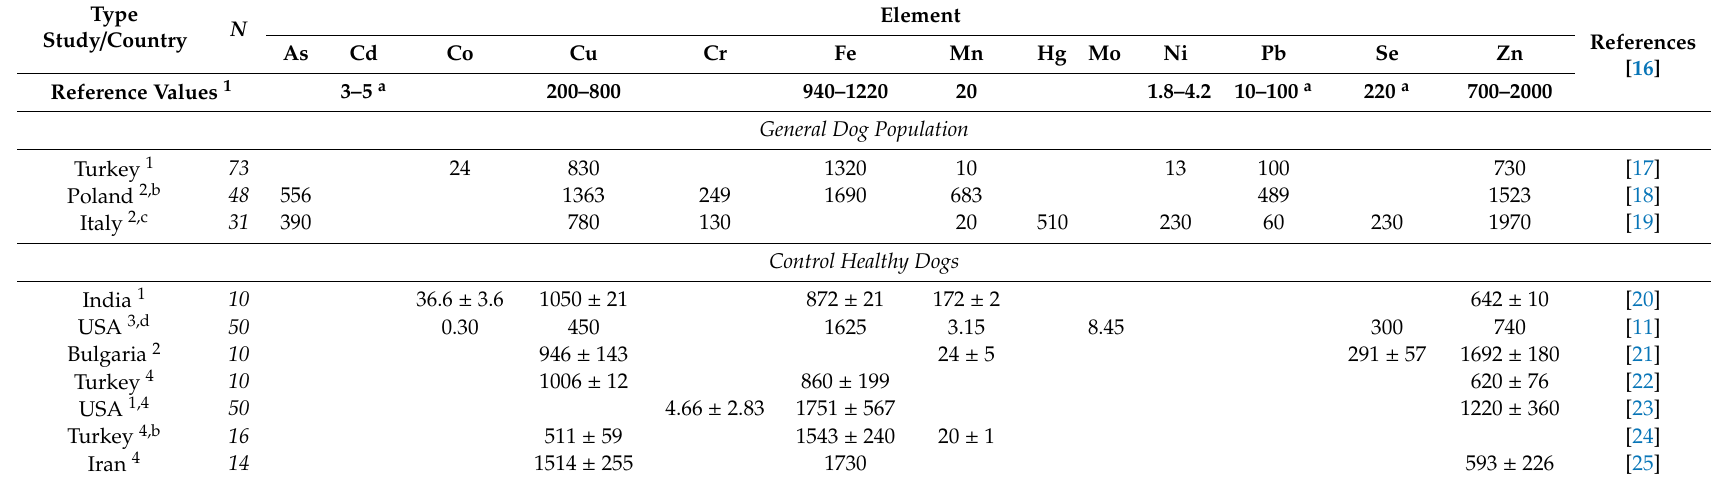
Table 3. Serum concentrations of essential trace and toxic elements (expressed in µ g L − 1 and arithmetic mean values) in observational studies in